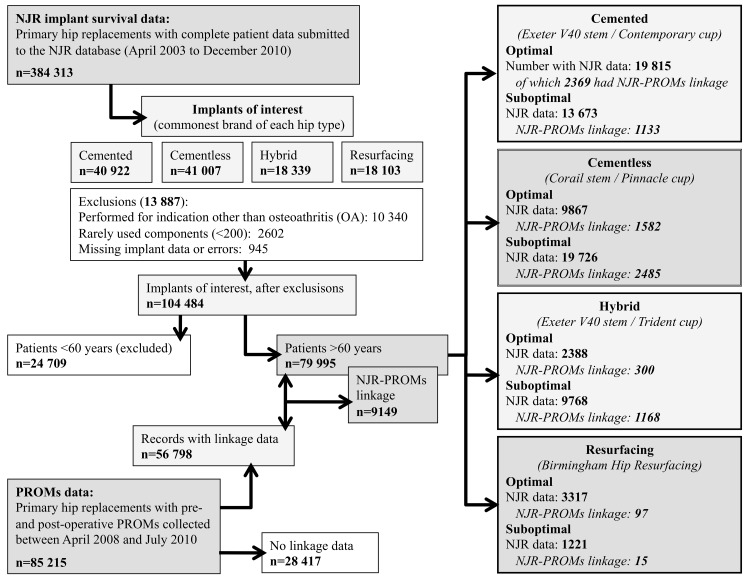
Flowchart describing inclusion criteria and study populations.